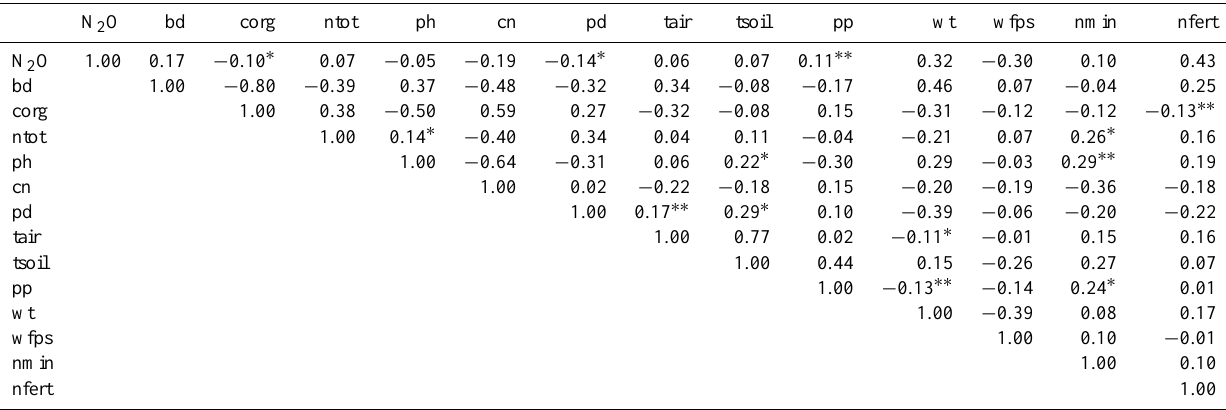
Table 2. Correlation matrix of N 2 O fluxes and potential driving parameters for the available dataset from organic soils in Europe. The parameter names are described in Table